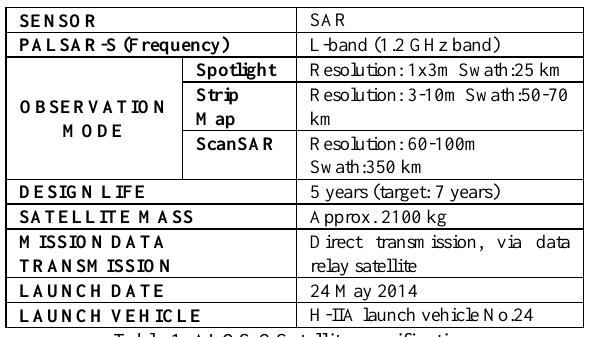
Table 1. ALOS-2 Satellite specifications